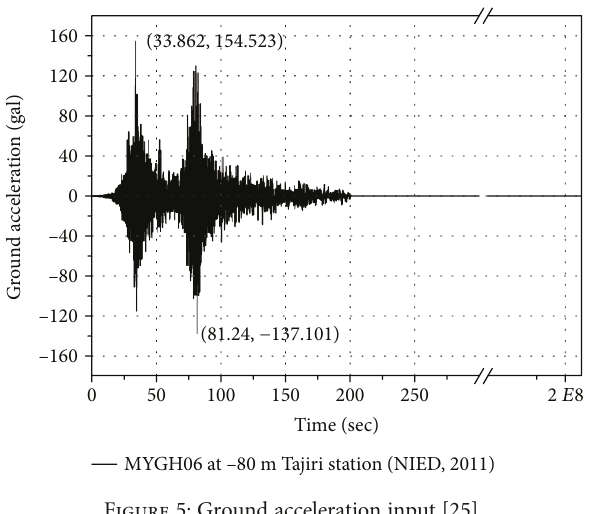
Figure 5: Ground acceleration input